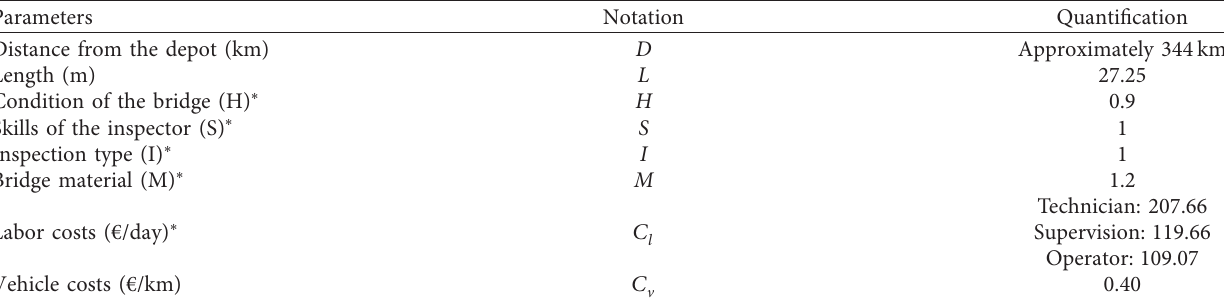
Table 9: Quantification of the variables for inspection costs.